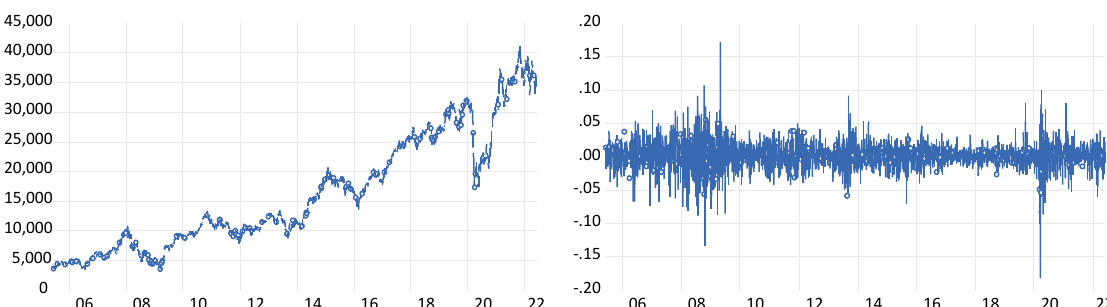
Figure 1. The trend (Closing prices) and log-returns of the Bank NIFTY index during the sample